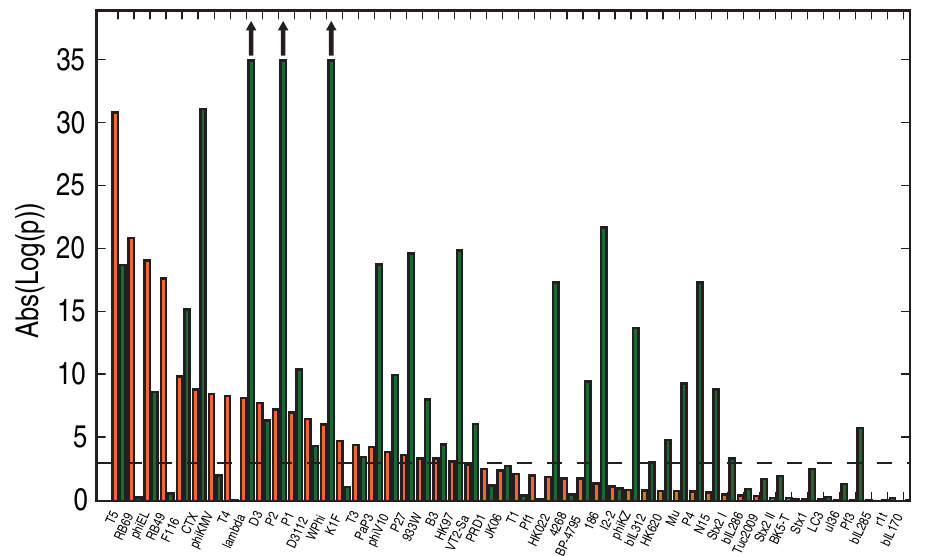
Figure 8. Combined Fisher p-values for the green and orange randomization tests across 50 phage genomes. Phage names are listed on the x-axis, and are sorted by their orange p -value. A total of 29 genomes exhibit non-random GC3 content controlling for CAI (green test); and a total of 22 genome exhibit non-random CAI content controlling for GC3 (orange test). 17 genomes pass both of these tests. The dashed horizontal line indicates the threshold for significance after Bonfernni correction (i.e. 5%/50). Upwards arrows indicate p-values that lie beyond the limits of the y-axis. See Table 2 for phage properties, including the p -values for these tests. Twenty four phage genomes that failed the aqua GC3 or CAI control tests are not included in this figure.